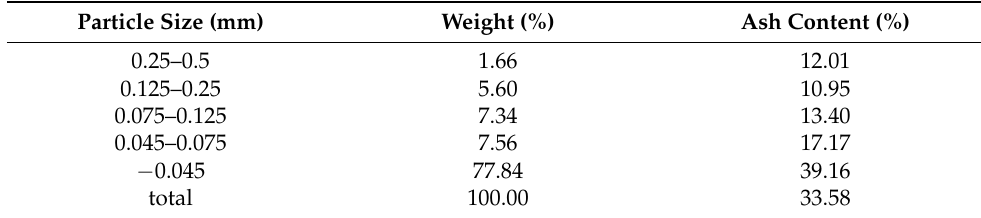
Table 2. Particle size distribution of slime sample used in this study.